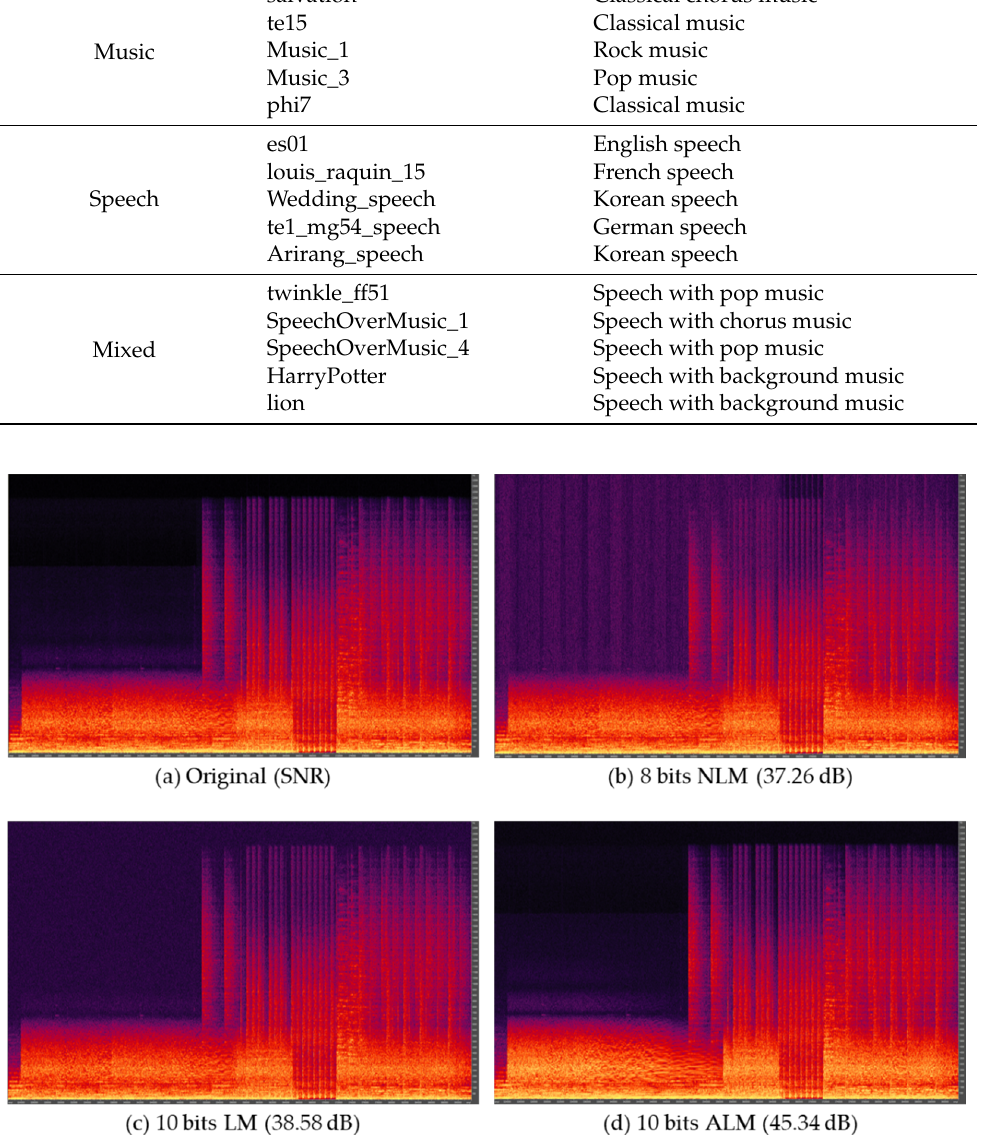
Figure 8. Spectrograms of the music_1 audio signal.